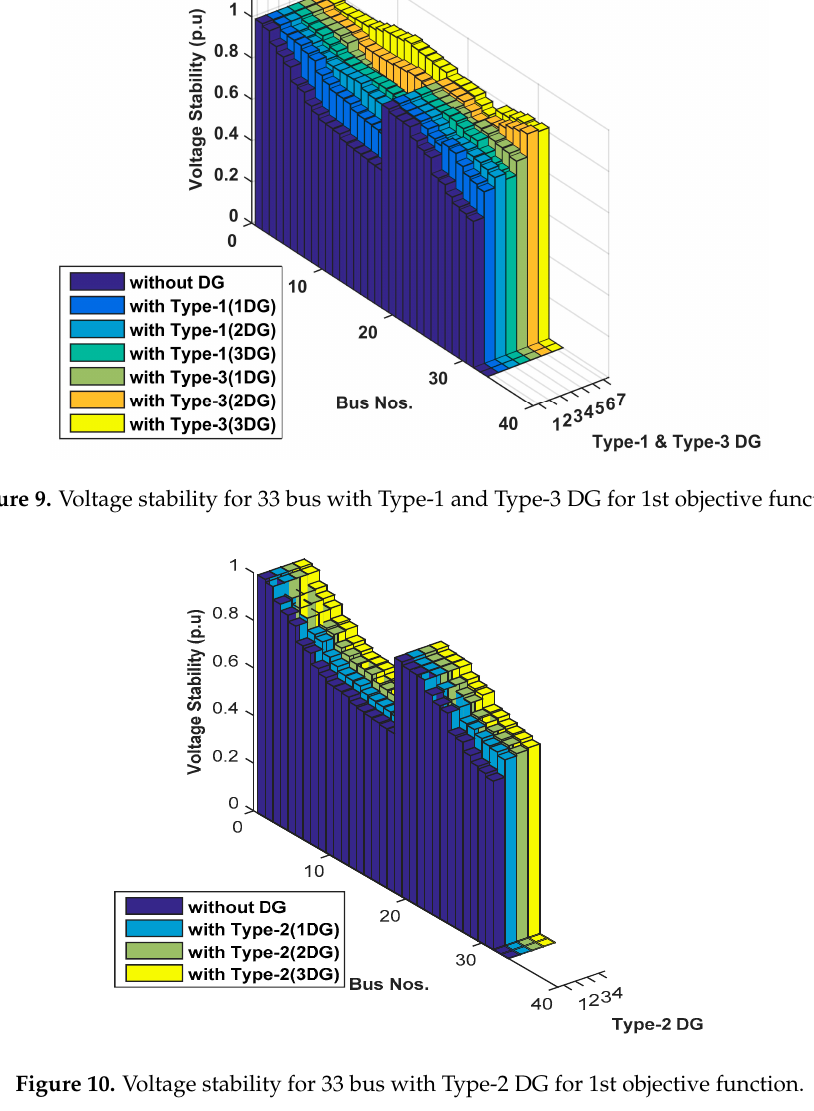
Table 4. Optimal placement and sizing of DG for case-1 as single-objective function with priority to 2nd objective function.